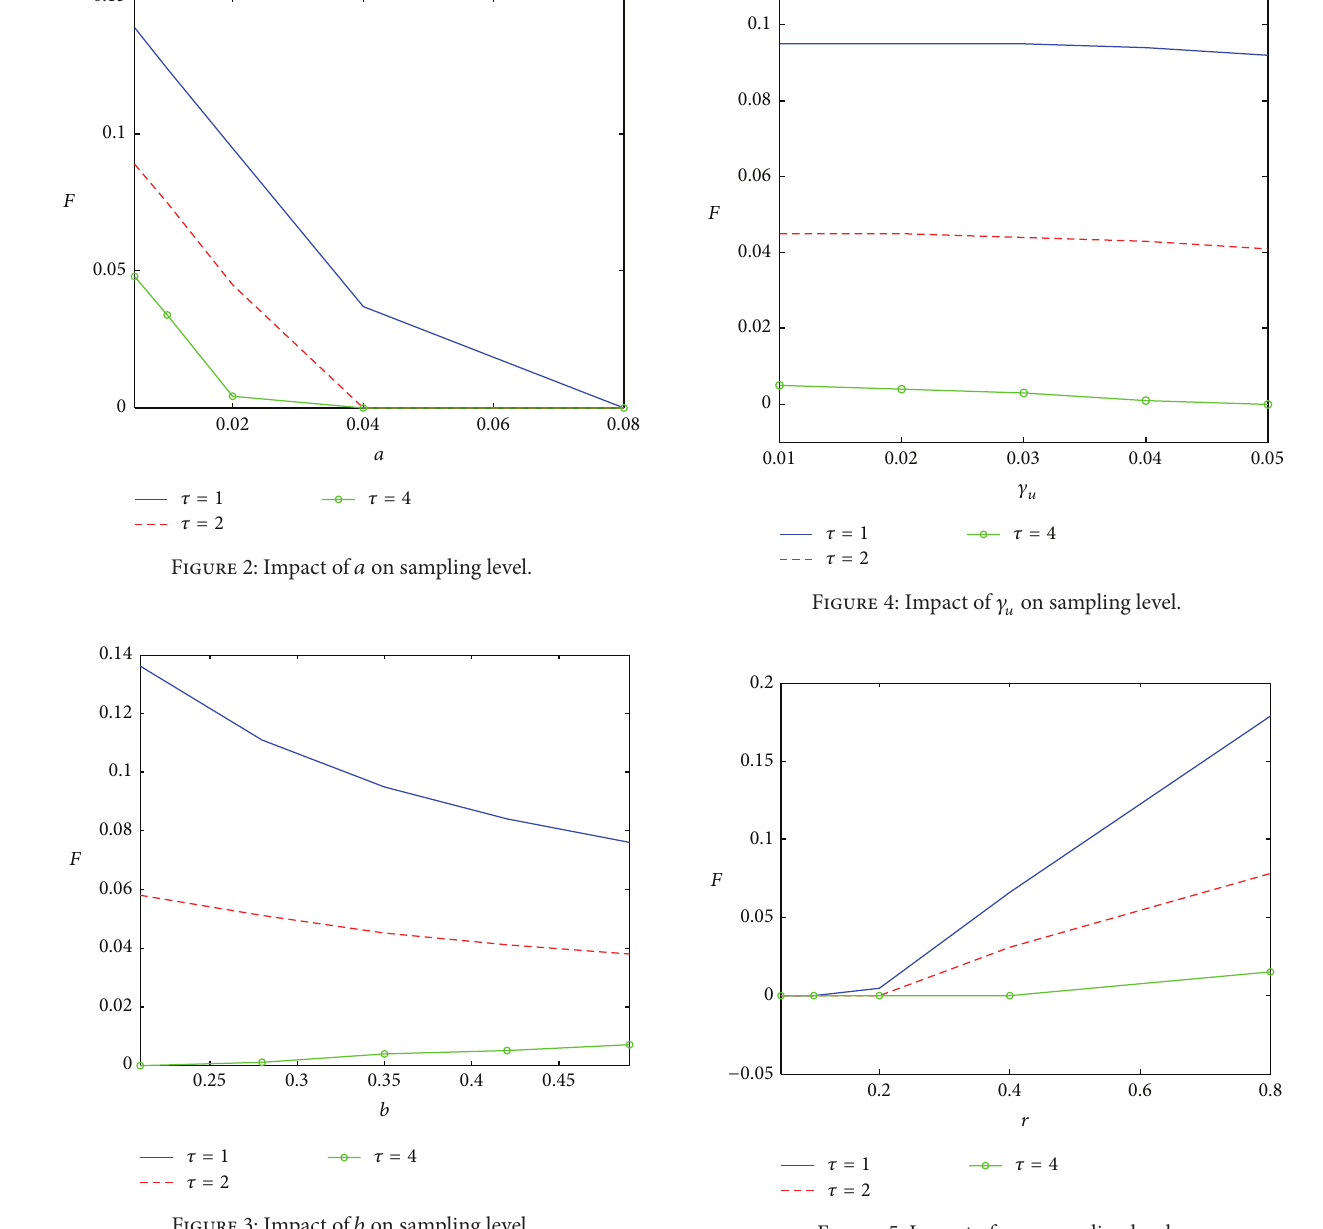
Figure 5: Impact of 𝑟 on sampling